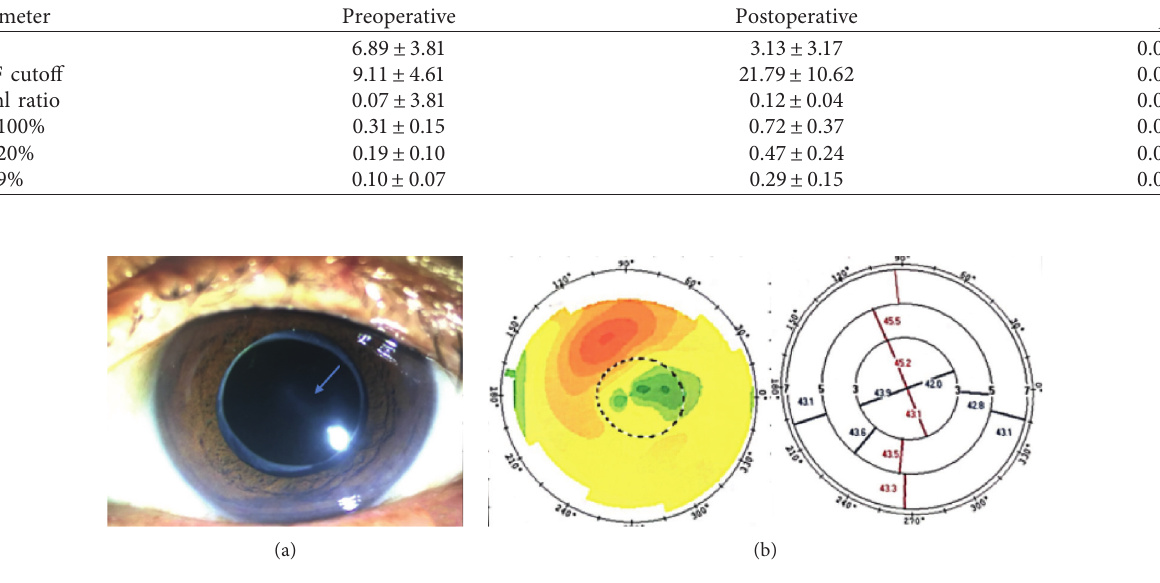
Figure 8: A photo of an eye with an old central traumatic scar and its topography. The scar is indicated by the blue arrow in